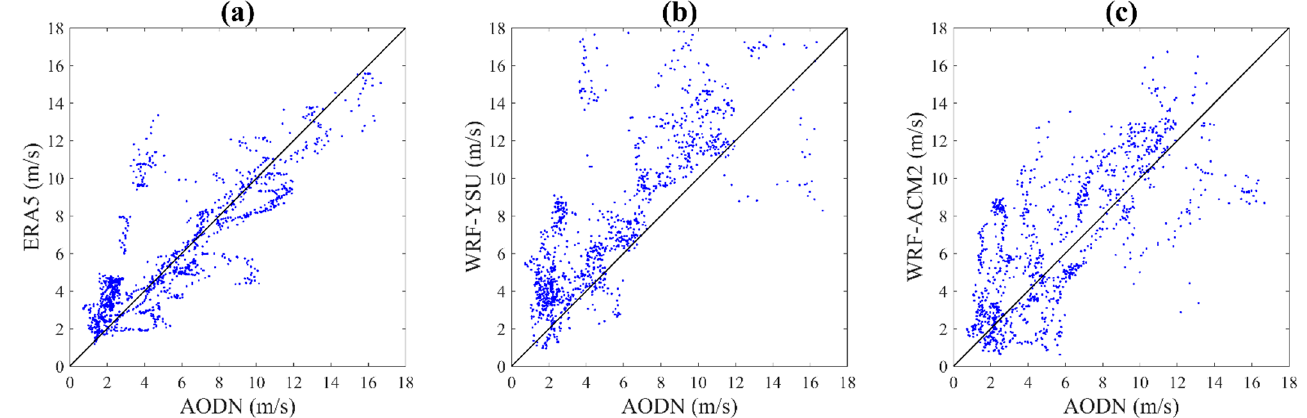
Figure 8. The scatter plot of wind speeds (blue dots) from ( a ) ERA5, ( b ) WRF model with YSU, and ( c ) WRF model with ACM2 for PBL vs. AODN recorded wind speed (altimeter) from 30 September to 4 October 2021. The black line shows the 1:1 slope in each case.